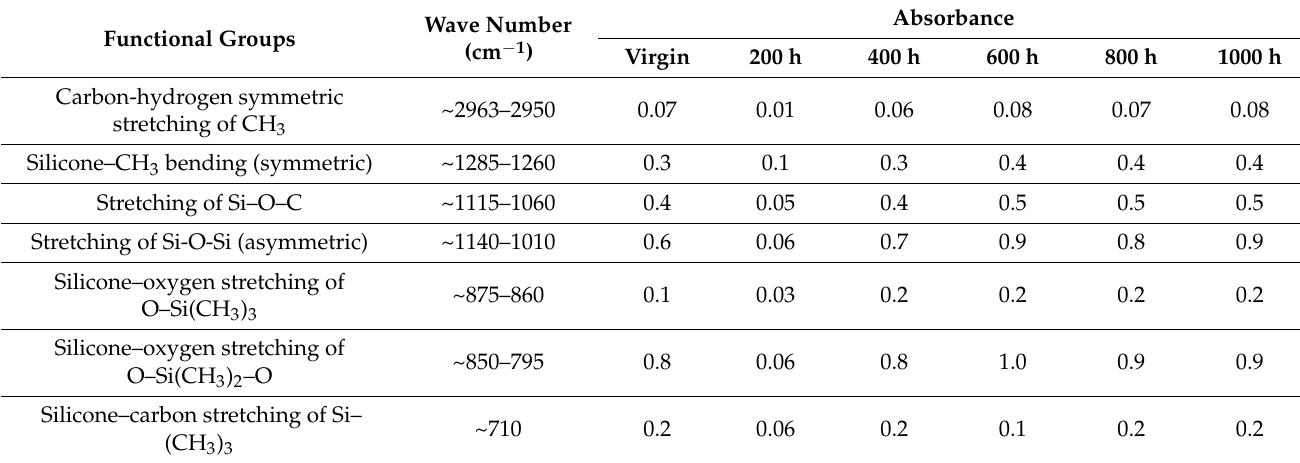
Table 5. Peak absorption of major groups in SNC 2.5 from virgin to 1000